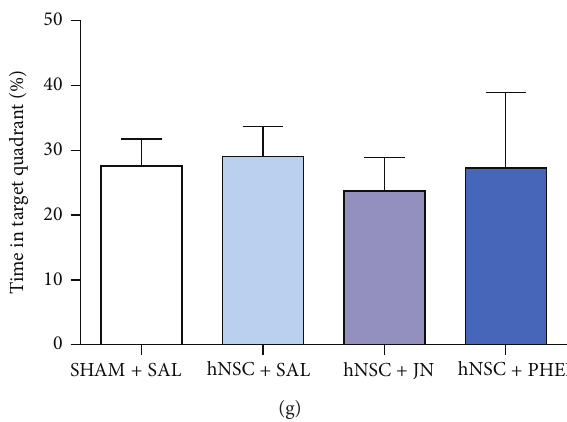
Figure 1: Intrahippocampal hNSCs transplantation affects spatial navigation memory in Tg2576 mice. Learning and memory were assessed in 5- to 7-month-old wild type (wt, 𝑛 = 6 ) and Tg2576 (APPswe, 𝑛 = 6 ) mice in the pilot Morris water maze task. (a) Escape latency during 4 days of acquisition training. (b) Latency to the former location of the platform or (c) the number of platform crosses in a probe test 24 hours later. ∗ 𝑝 < 0.05 compared to wild type. The data are expressed as means ± SEM. (d) The experimental design of the study with 6- to 9-month- old Tg2576 mice ( 𝑛 = 30 ) comprised (i) Morris water maze tests with 5 days of acquisition followed 24 hours later by a probe memory test, (ii) daily intraperitoneal injections of 0.3 mg/kg JN403 or 25 mg/kg (+)-phenserine for 5 weeks in total, (iii) bilateral hippocampal injections of ∼ 25,000 hNSCs/hemisphere after 1 week of drug treatment, (iv) repetition of the Morris water maze tasks 5 weeks after transplantation, and (v) sacrifice by transcardial perfusion with PBS. (e) Time taken to find the former platform location in the baseline and follow-up test. (f) Differences in time taken to find the former platform location ( Δ latency; follow-up probe test values minus baseline probe values). (g) Percent time spent in the target quadrant where the platform was located. ∗ 𝑝 < 0.05 compared to SHAM + SAL. The data are expressed as means ±